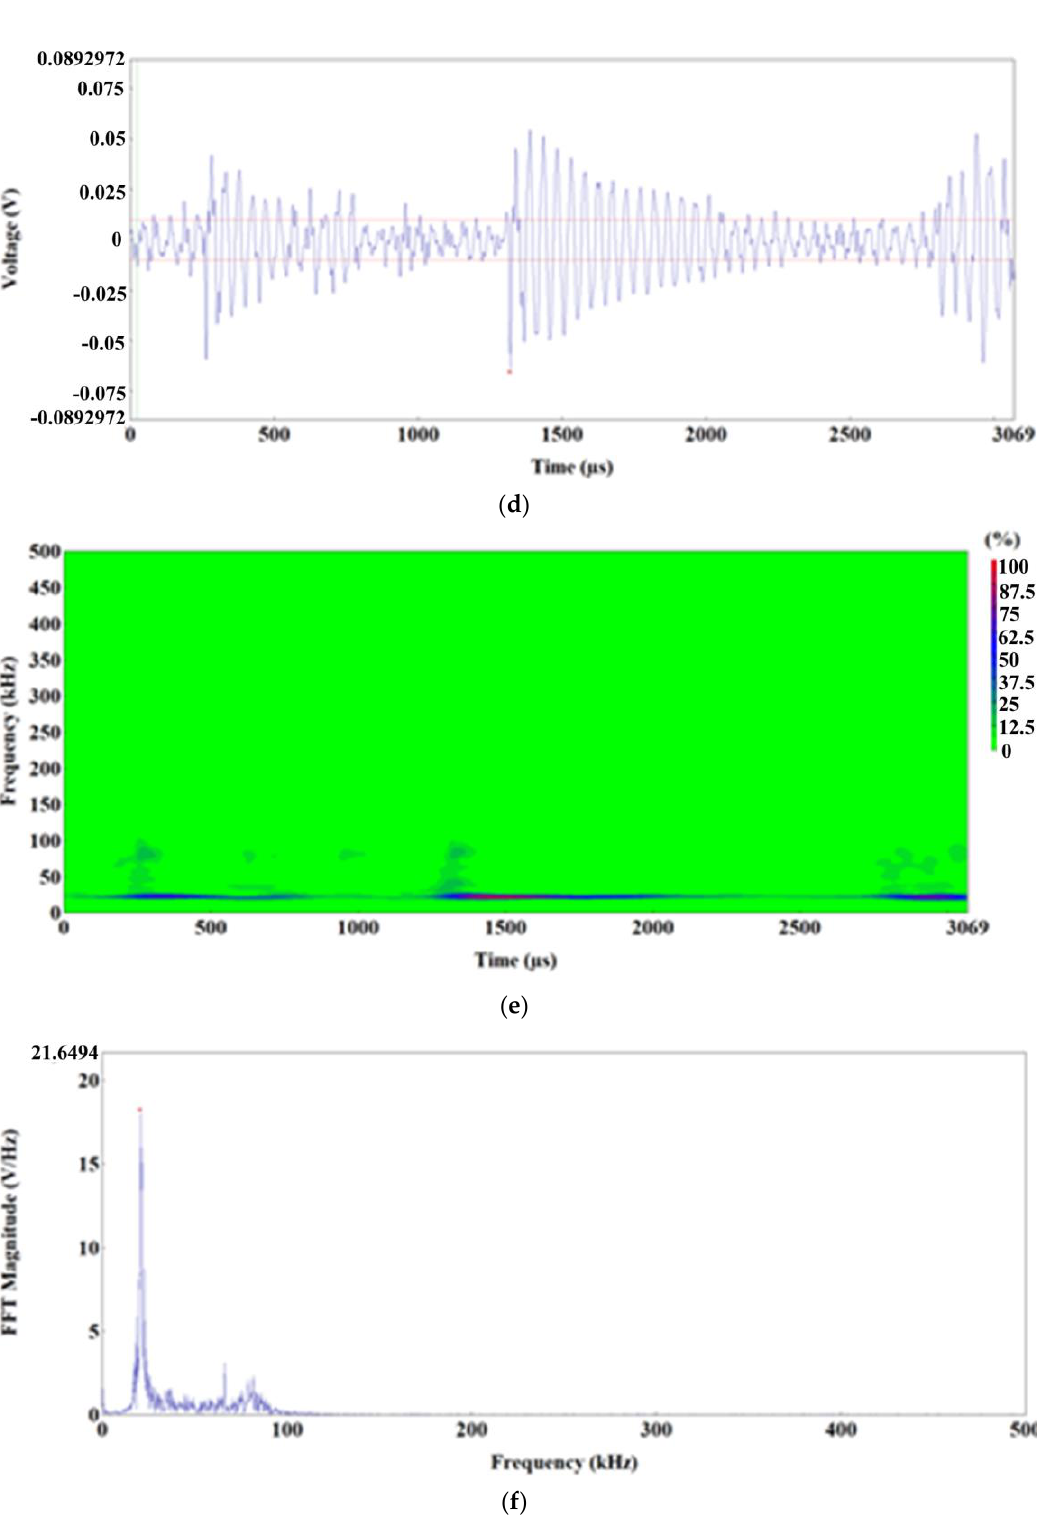
Figure 17. Time-frequency charts for the time of specimen failure: ( a , d ) Waveform Time Domain graphs, ( b , e )Waveform Continuous Wavelet graphs, ( c , f ) FFT Magnitude graphs.